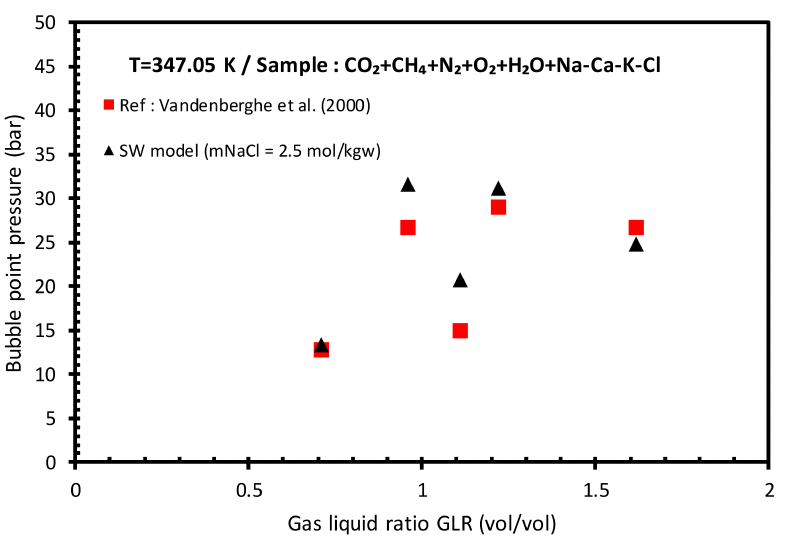
Figure 12. Comparison of the predicted (black symbols) bubble pressures with those from literature (red symbols) [31] at different values of GLR and at 2.5 mol/kgw of